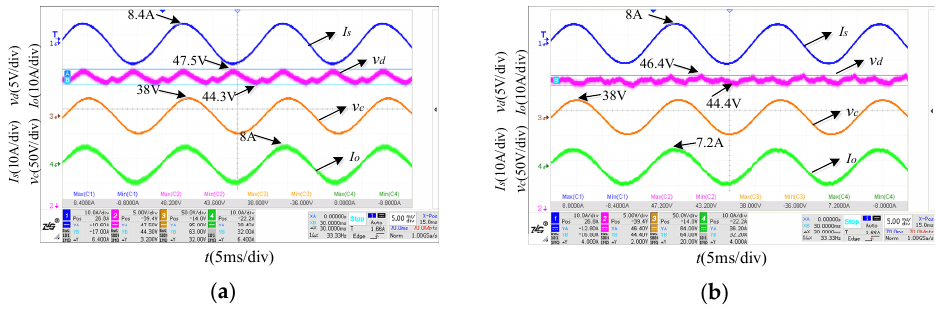
Figure 13. Output waveforms: ( a ) traditional modulation strategy; ( b ) improved modulation strategy.